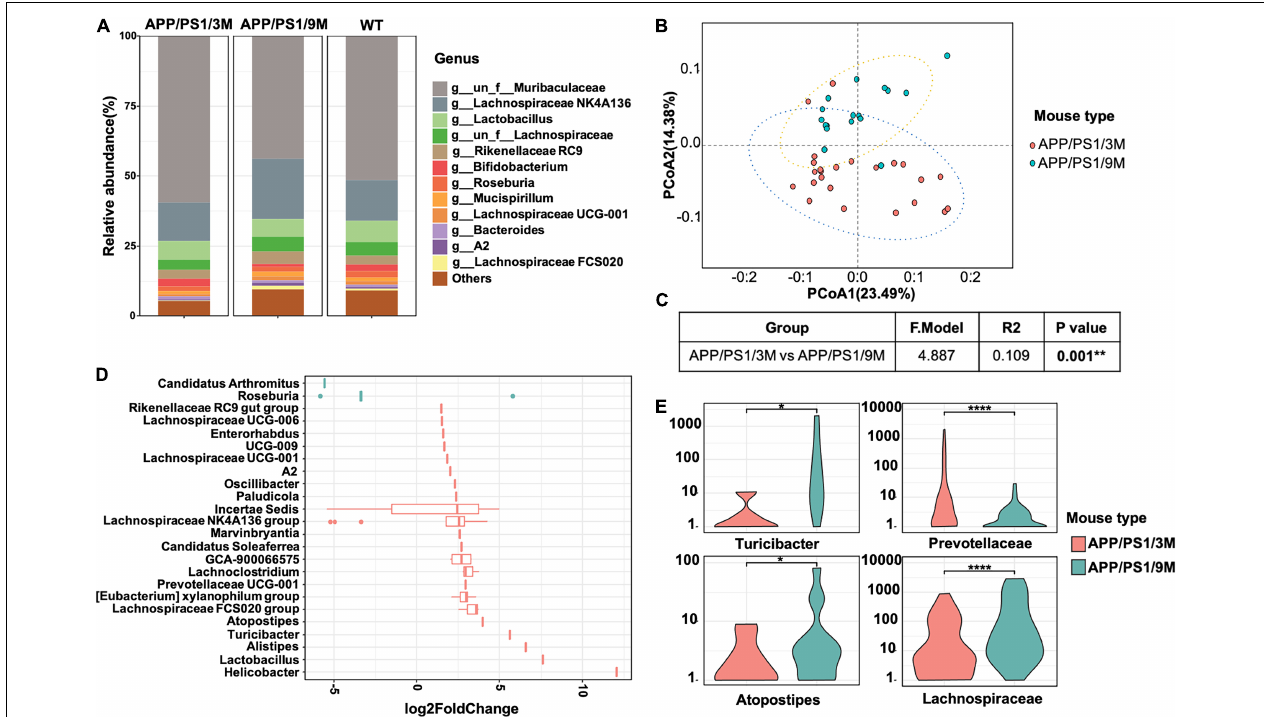
FIGURE 6 | Comparison of microbiome composition of APP/PS1 mice at 3 and 9 months old. (A) The relative abundance of top microorganisms in the feces of 3 and 9-month-old APP/PS1 mice and age-matched C57/BL/6 mice. (B) Principal coordinate analysis (PCoA) based on weighted UniFrac phylogenetic distance to compare 3 and 9-month-old APP/PS1 mice. (C) Comparison of beta diversity between 3 and 9-month-old APP/PS1 mice based on weighted UniFrac phylogenetic distance. The data was calculated using permutational multivariate analysis of variance (PERMANOVA) by R package ‘vegan.’ ** p < 0.01. (D) Significant difference in the bacterial genus with relative abundance ≥ 0.01% between 3 and 9-month-old APP/PS1 mice. (E) The main genus of APP/PS1 mice with significant differences at 3 and 9 months. Comparisons of the relative abundance of gut microbiota between groups at the genus level were performed using two-tailed Wilcoxon rank-sum tests. Statistical significance is indicated in the figures by * p < 0.05, ** p < 0.01, and **** p <